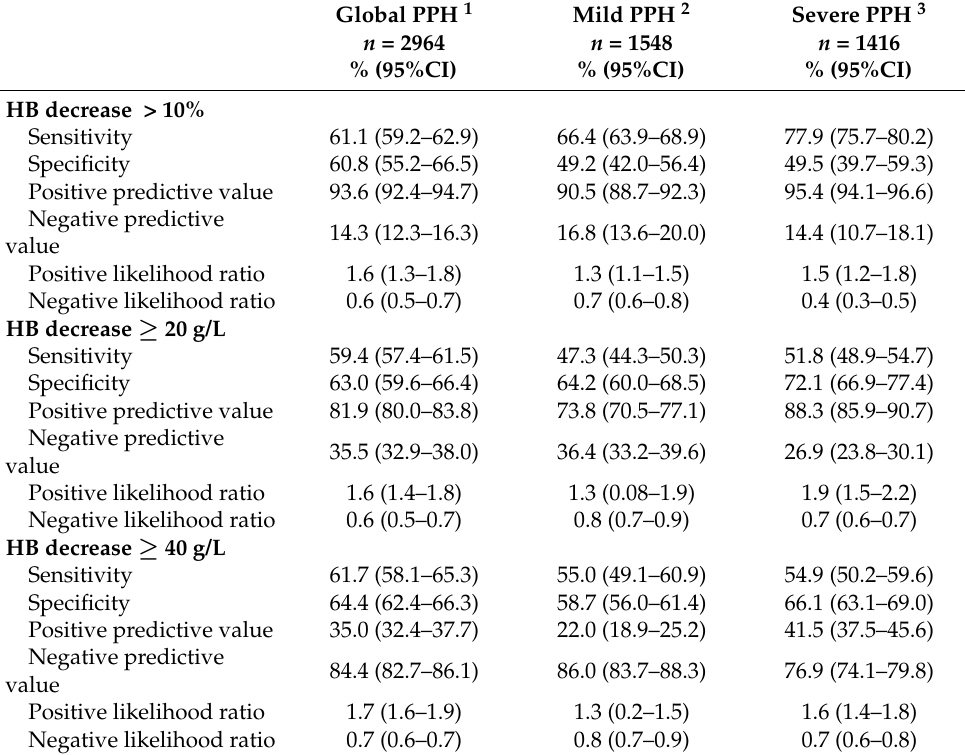
Table 3. Performances of the different changes in hemoglobin thresholds as a diagnostic test for PPH. Global PPH